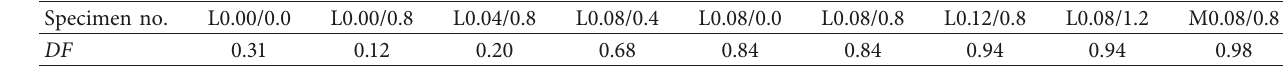
Table 3: Test results of the DF of SFRELC.